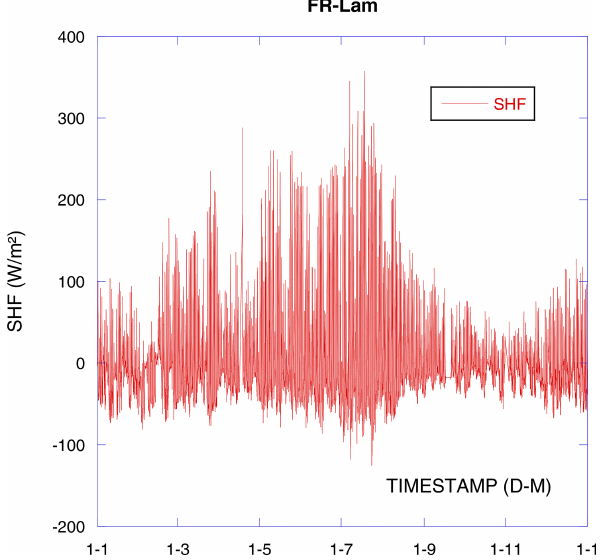
Figure 2. Soil heat flux integrated for 1